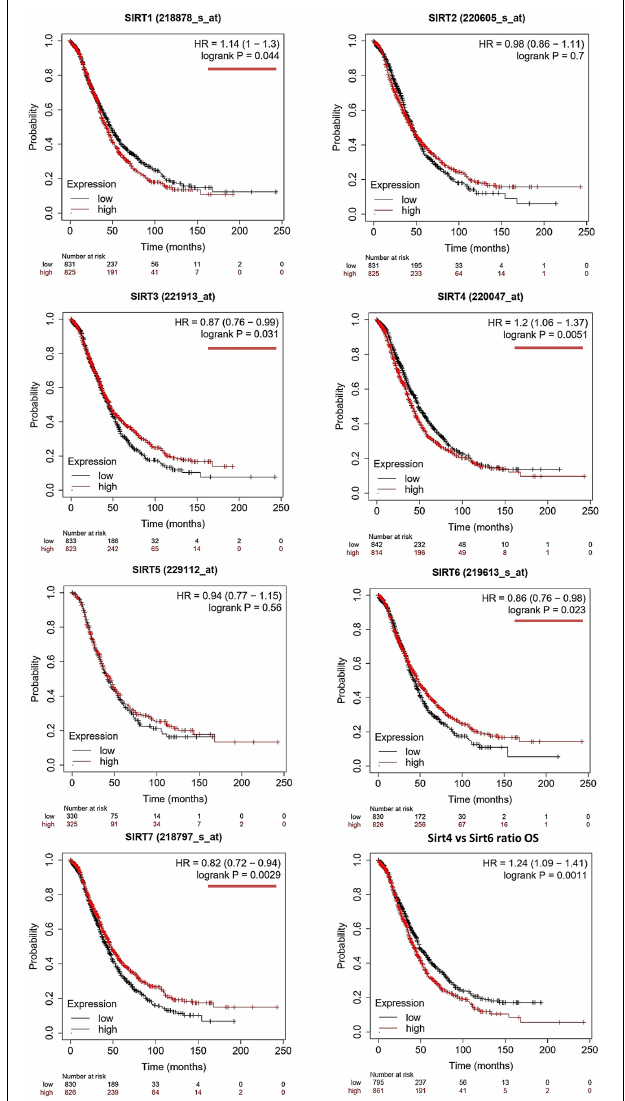
FIGURE 1 | Prognostic values of the sirtuin family members with probe IDs in ovarian cancer patients, as obtained using the Kaplan–Meier (KM) Plotter ( n = 1,656) for overall survival (OS) analysis. A log-rank p < 0.05 was considered statistically significant and is marked with a red underline . The median expression level was set as the cutoff for the KM plot. The red line indicates high expression and the blue line indicates low